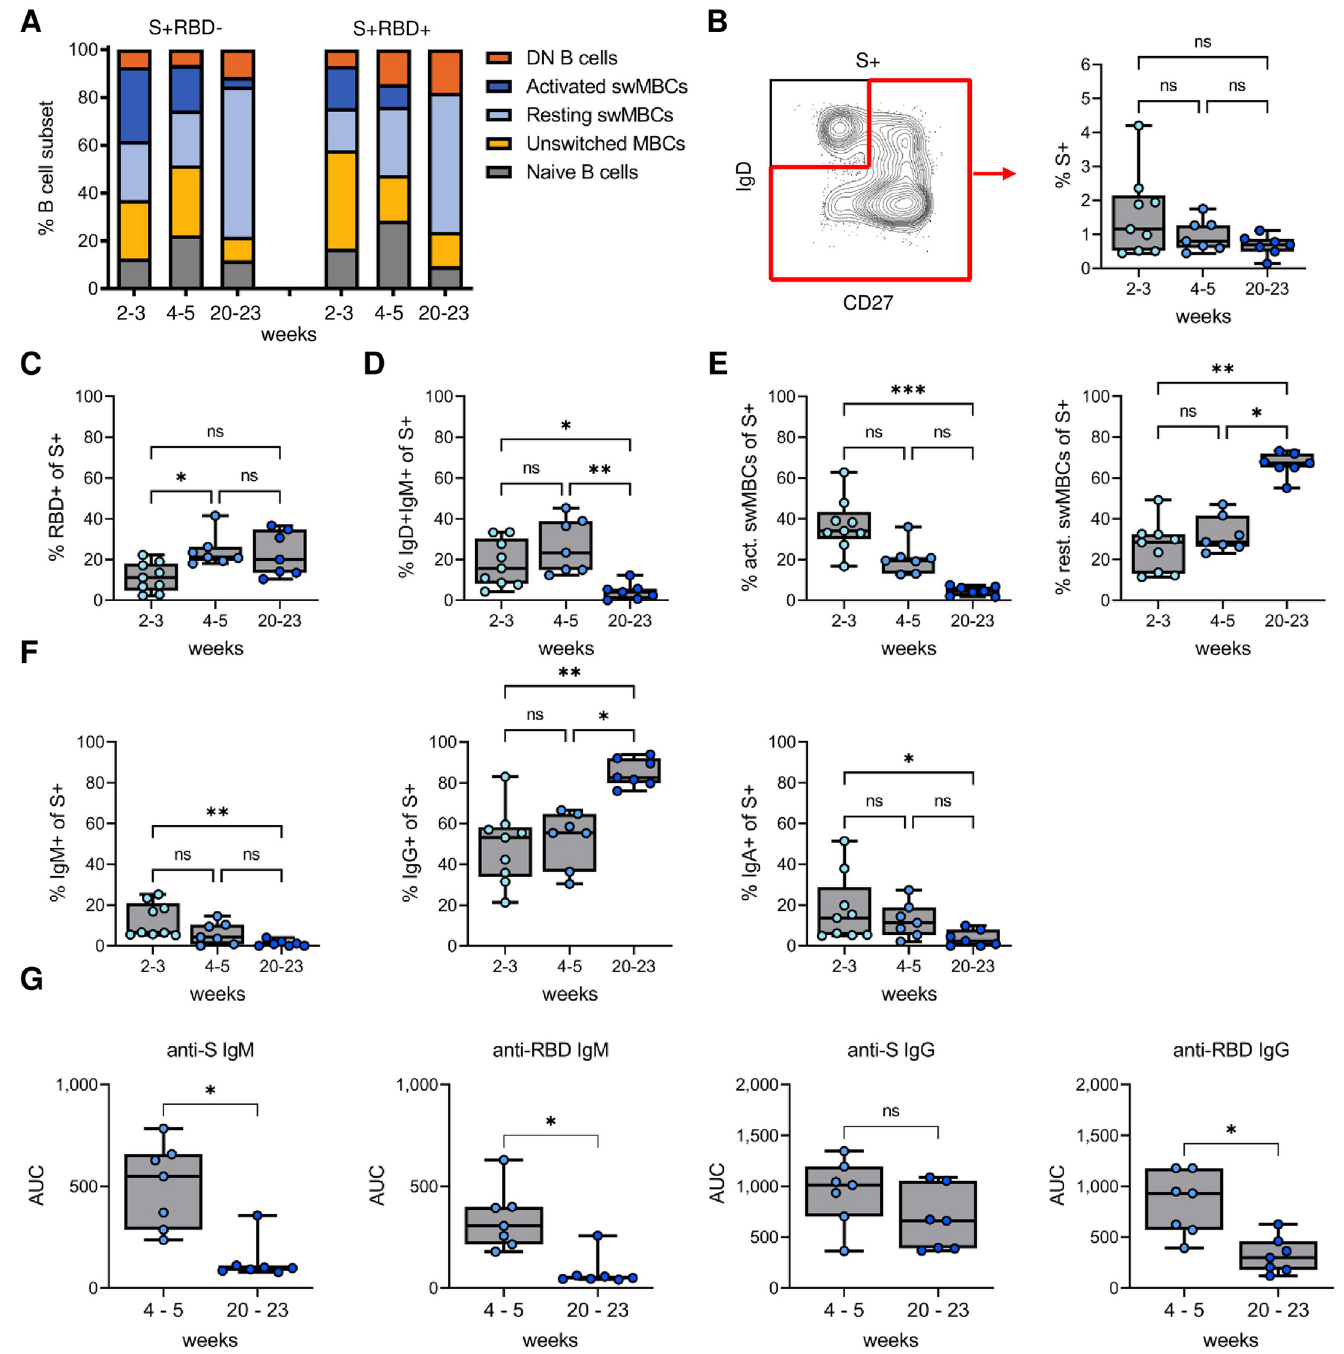
Fig 6. Change from activated to resting memory phenotype of IgG + spike-specific B cells at five months post-symptom onset. A) Phenotype distribution of non- RBD-specific (S+RBD-) and RBD-specific (S+RBD+) B cells, showing the median percentage among each group. Graphs with individual data points for each B cell subset are presented in S6 Fig. B) Percentage of antigen-experienced spike-specific B cells at 2–3, 4–5, and 20–23 weeks post-symptom onset. C) Percentage of S+RBD + B cells among antigen-experienced spike-specific B cells. D) Percentage of unswitched memory B cells among antigen-experienced spike-specific B cells. E) Percentage of activated (left) and resting (right) switched memory B cells among antigen-experienced spike-specific B cells. F) Percentage of class-switched spike- specific B cells that express IgM (left), IgA (middle), or IgG (right). G) Plasma IgM (left) and IgG (right) titers against spike and RBD. In all panels, results are shown for samples collected 2–3 (n = 9), 4–5 (n = 7), and 20–23 (n = 7) weeks post-symptom onset. � P < 0.05; �� P < 0.01; ��� P < 0.001.